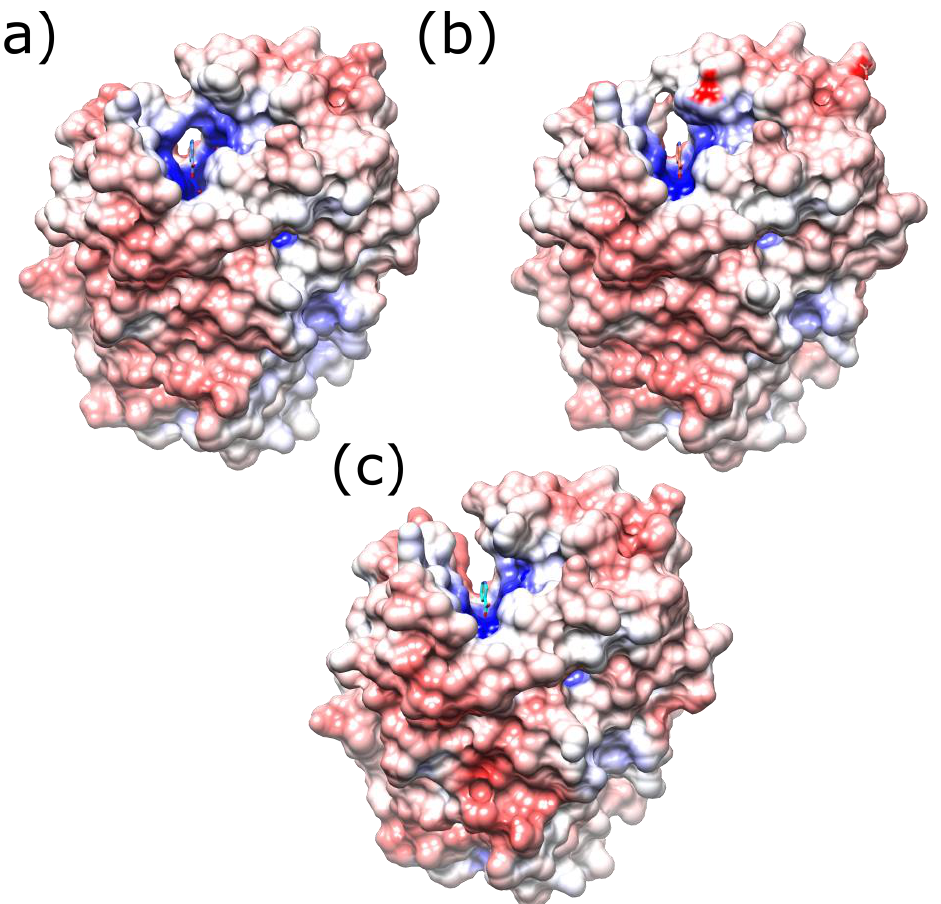
Figure 7. Electrostatic surface representation of wild-type and mutant NfsB, looking into the minor channel to the active site. ( a ) Wild-type protein; positively charged residues are coloured blue, negatively charged ones are coloured red, and the structure of the bound nicotinate is shown in blue with CPK colouring for the oxygen and nitrogen. ( b ) T41Q/N71S/F124T NfsB and ( c ) T41Q/N71S/F124T/M127V NfsB in the same orientation as the wild-type protein.